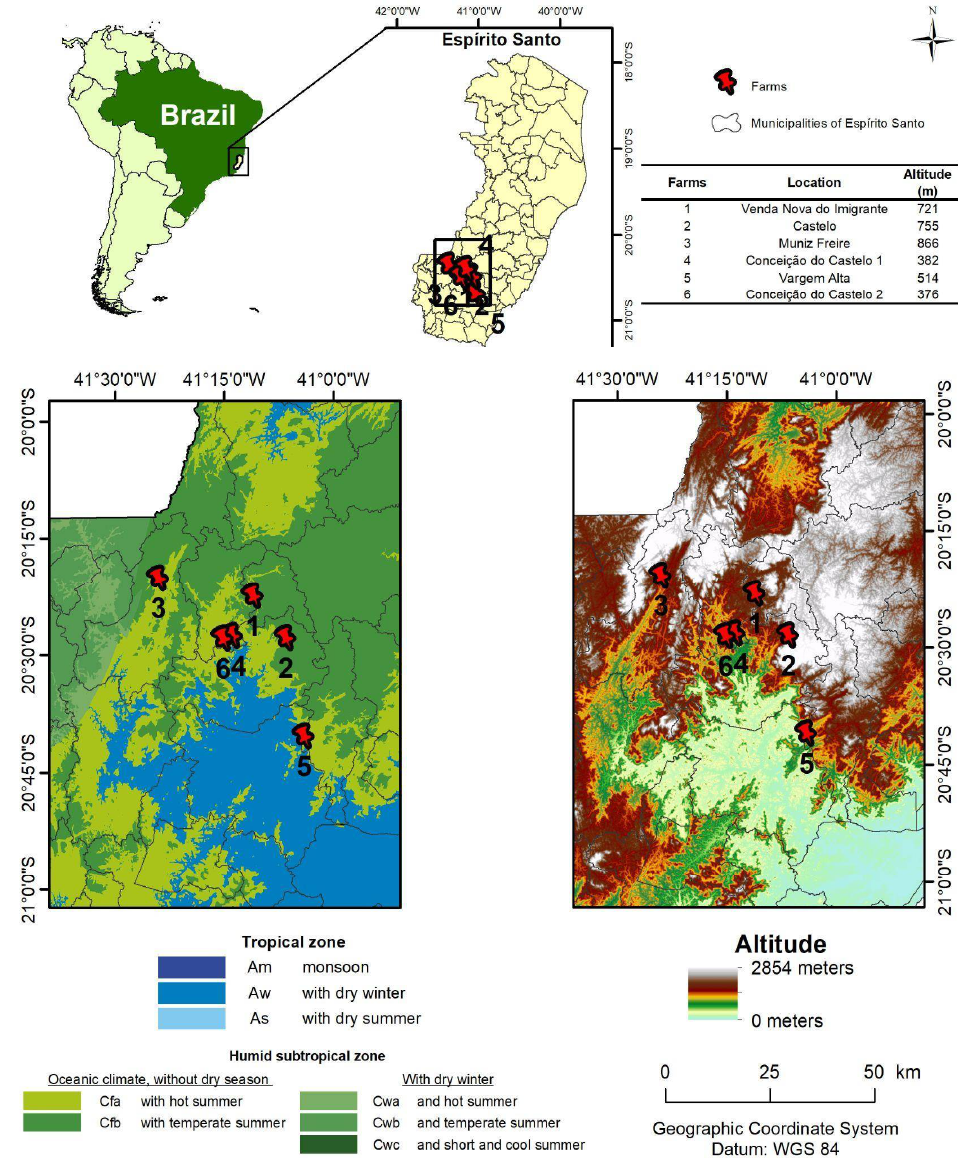
Figure 1. Location map of the farms, showing the climate and altitude of the areas under study. Farms are represented by their identification numbers that range from 1 to 6, where Venda Nova do Imigrante (1), Castelo (2), Muniz Freire (3), Conceição do Castelo 1 (4), Vargem Alta (5), and Conceição do Castelo 2 (6).